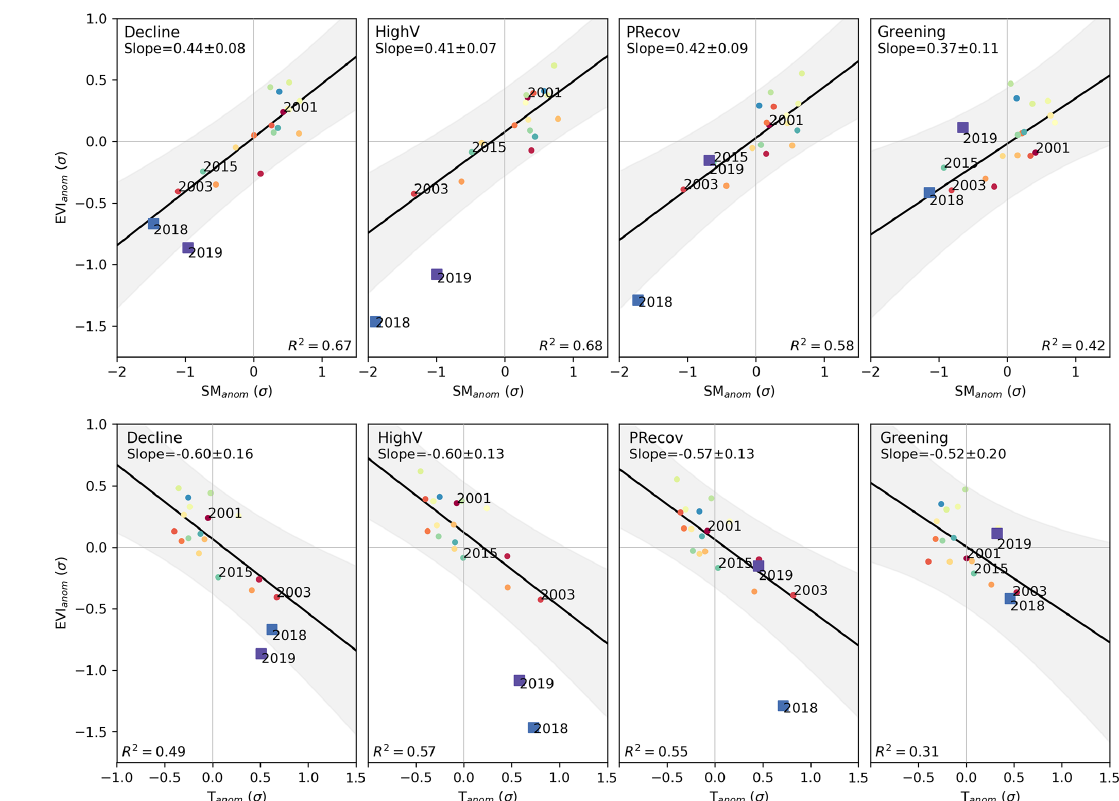
Figure 4. Departure of EVI anom in DH18 and DH19 from long-term climate-driven variability. Relationship between EVI anom and SM anom (top row) and between EVI anom and T anom (bottom row) for each individual summer between 2001 and 2019 over the study region. The results are shown separately for the four clusters defined in Fig. 3. The black line and shaded areas show the relationship and respective 95% confidence intervals obtained by ordinary least-squares linear regression between EVI anom and the respective climate variable for all years between 2001–2017. Values of (EVI anom , SM anom ) that deviate from the long-term relationships show increased sensitivity to climate anomalies, which can be a sign of increased vulnerability or decline. The colours indicate individual years, ranging from 2001 (red) to 2019 (purple), and square markers indicate 2018 and